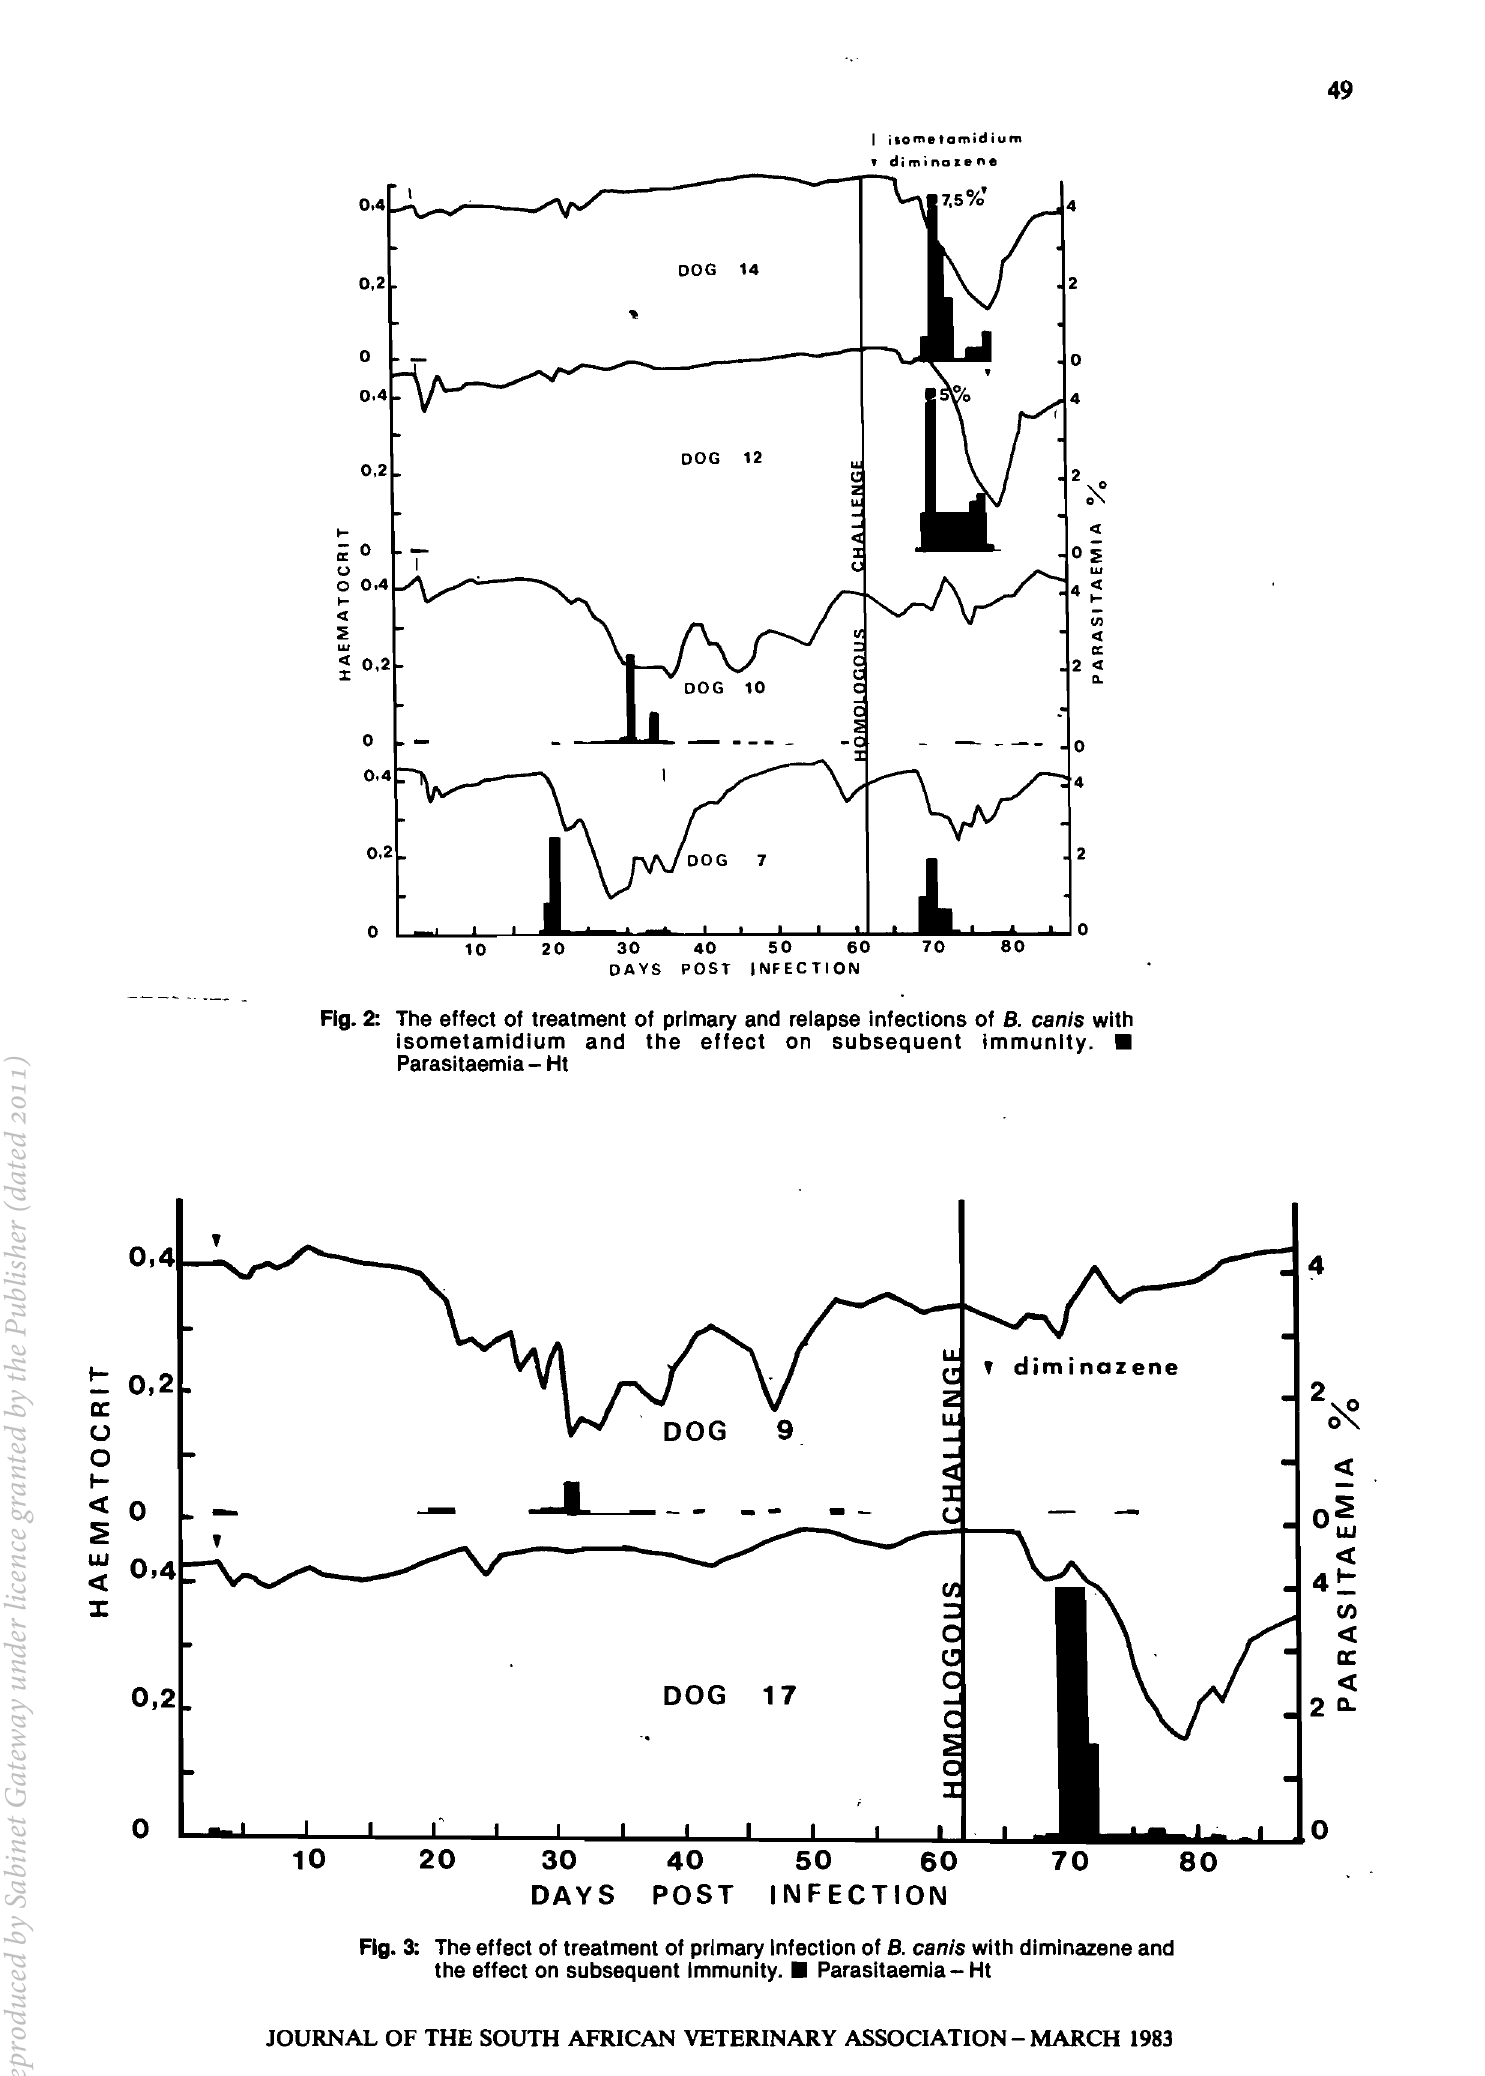
Fig. 3: The effect of treatment of primary Infection of B. canis with diminazene and the effect on subsequent Immunity .• Parasitaemia - Ht JOURNAL OF THE SOUTH AFRICAN VETERINARY ASSOCIATION-MARCH